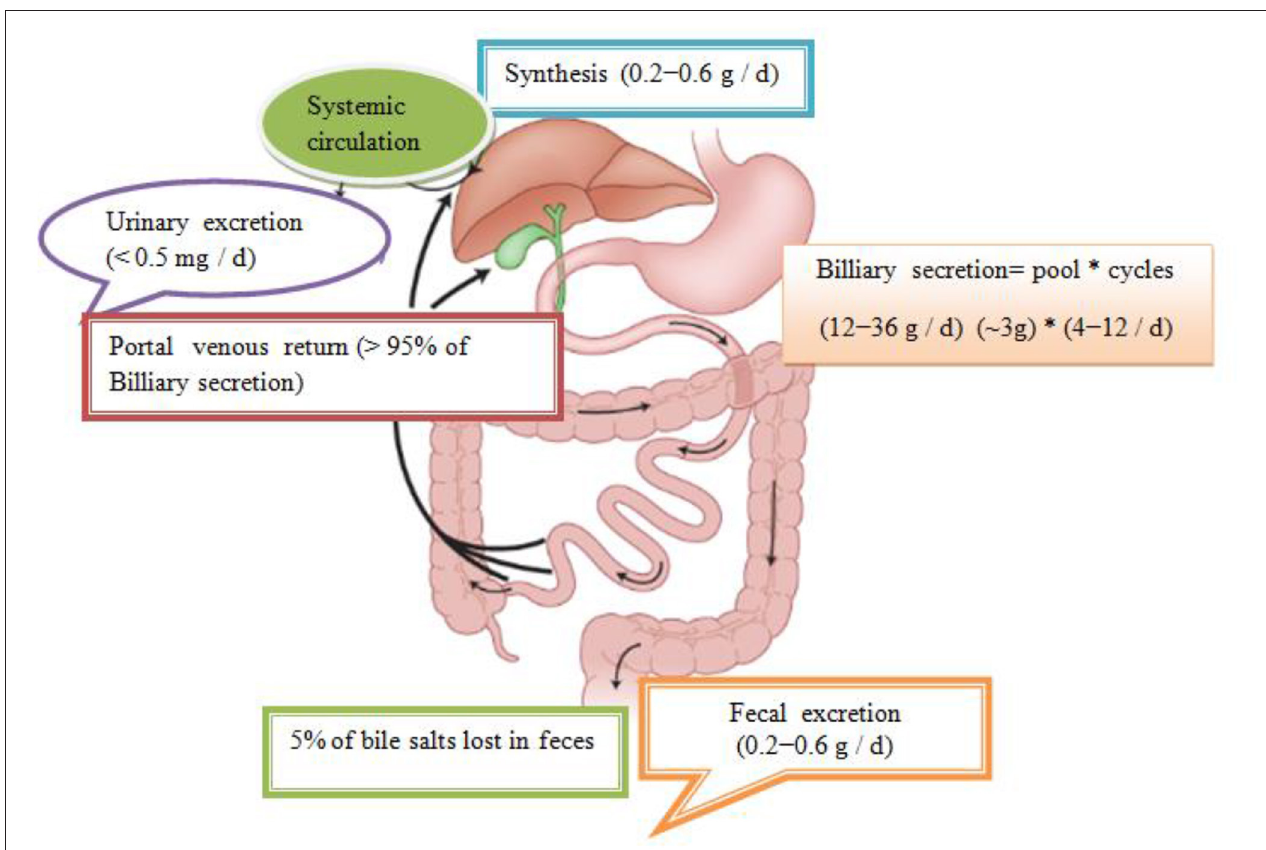
Figure 1 | Enterohepatic recirculation of bile salts. Bile salts entering the intestinal tract may be absorbed into the portal circulation where they can be removed from systemic circulation by hepatic uptake. The compound may then be excreted into the bile and pass back into the intestinal tract and become available for enterohepatic cycling. Biotransformation in enterocytes, hepatocytes, and the intestinal tract and throughout the body can convert the drug into metabolites, which may undergo enterohepatic cycling or escape into the urine and feces. Some very lipophilic solutes may bypass the portal circulation and be absorbed into the systemic circulation via the lymphatic system (Mikov et al.,